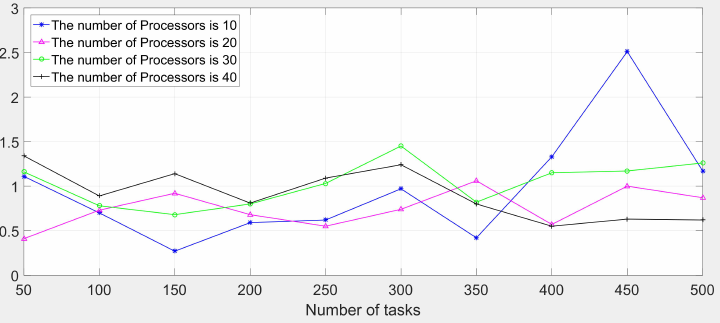
Figure 11. The average response time tests when the number of processors is 10, 20, 30, and 40.